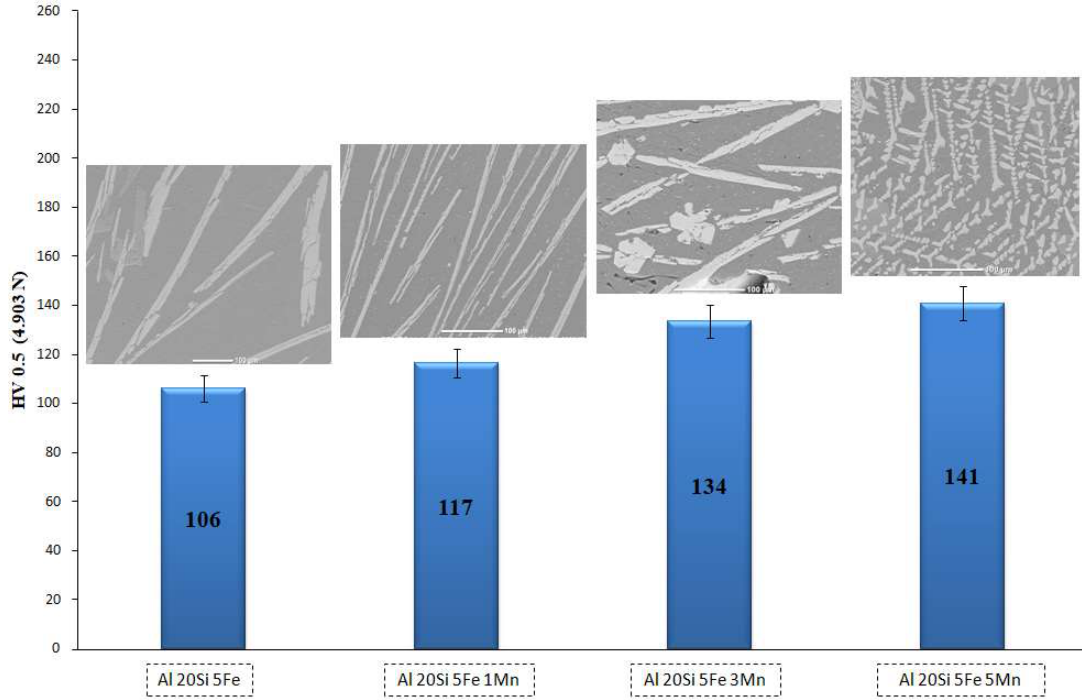
Figure 16. Microhardness of the Al–20Si–5Fe alloy with several Mn additions. Metals 2018 , 8 , x FOR PEER REVIEW